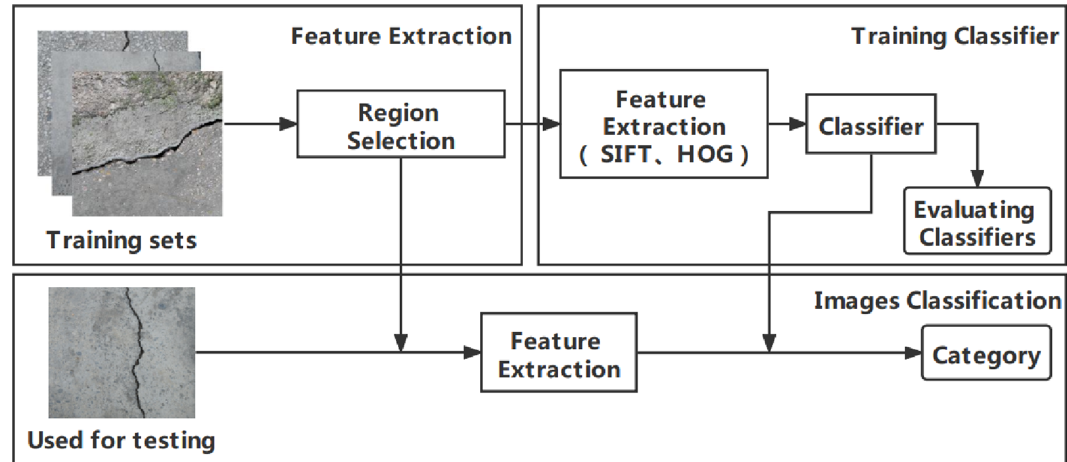
Fig. 1 Detection of bridge surface cracks using traditional object detection algorithms